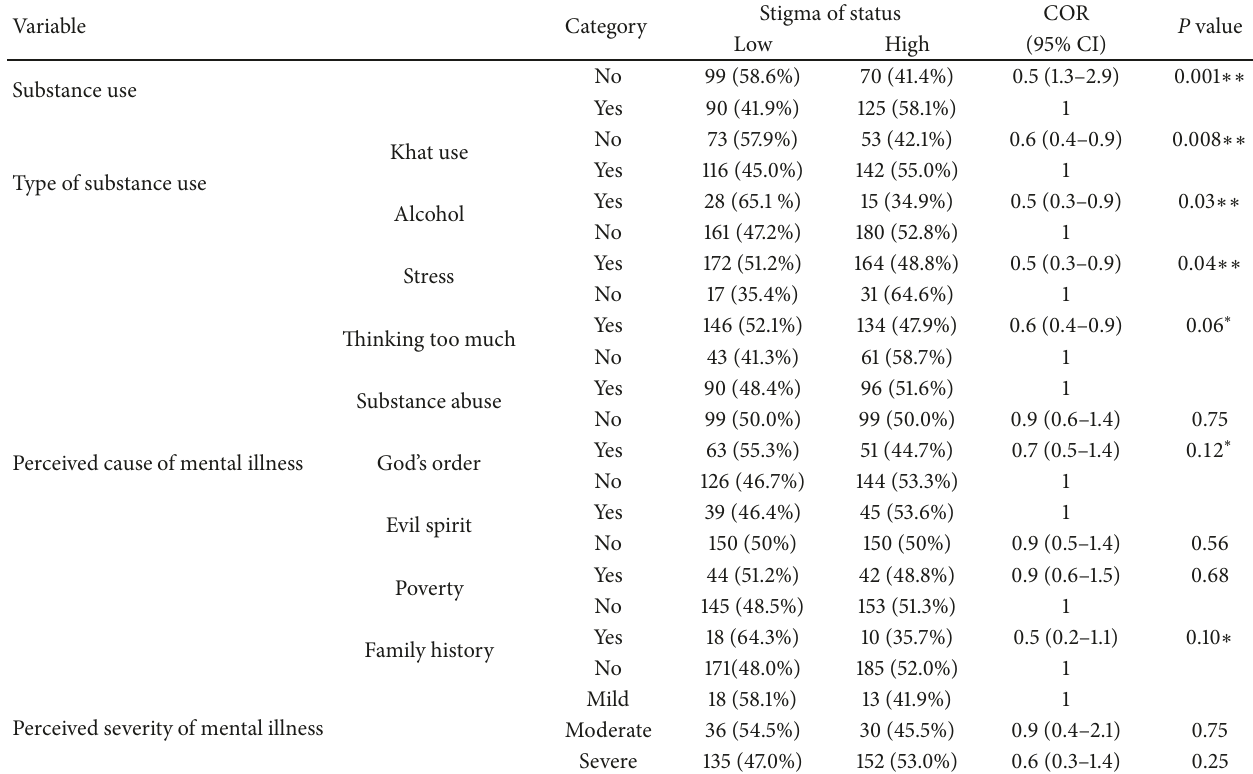
Table 4: Association of psychosocial factors with perceived stigma among adults with mental illness in JUSH, 2012.